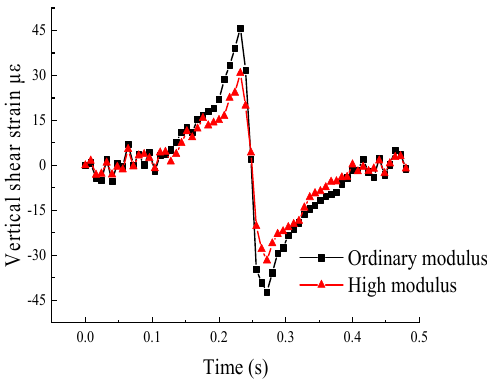
Figure 7. Comparison of vertical shear strain in the middle surface layer.